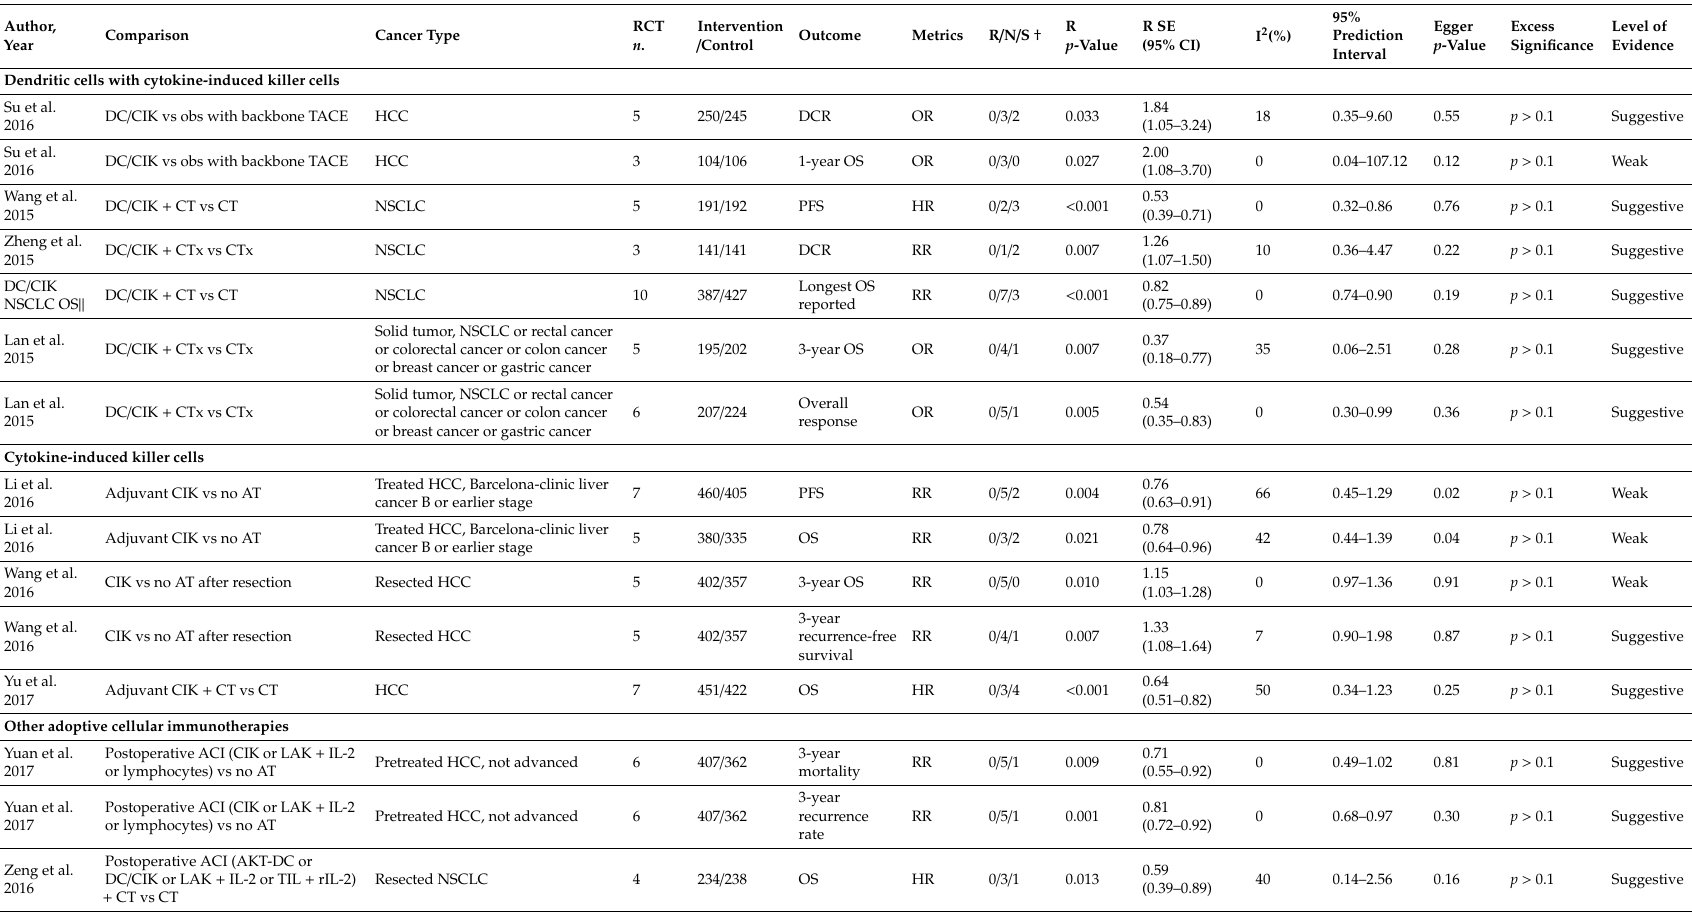
Table 2. Main findings and level of evidence reported in meta-analyses of adoptive cell immunotherapy for